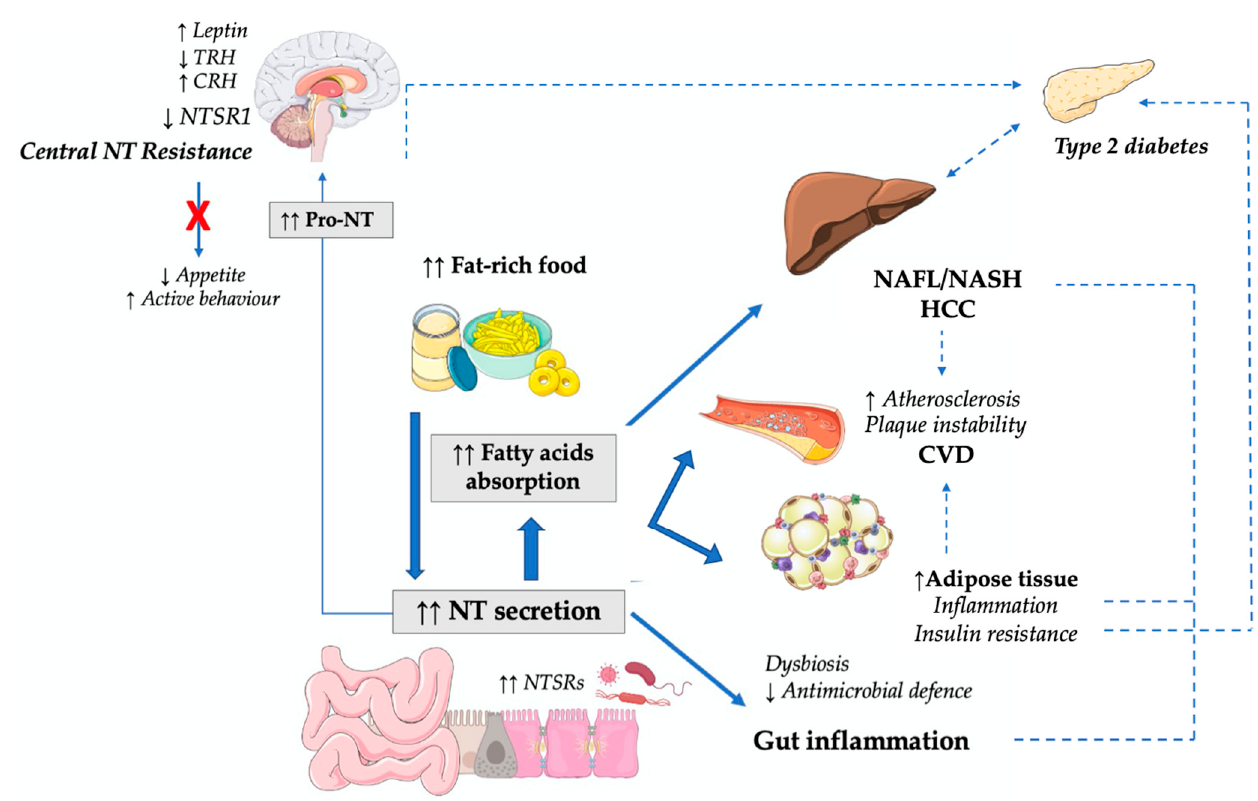
Figure 2. NT in metabolic diseases: potential direct and indirect mechanisms linking high NT to metabolic impairment and cardiovascular disease. Bold arrows indicate direct NT effects, dotted arrows show indirect NT influences on cardio-metabolic risk factors. Abbreviations: CRH: corticotropin-releasing hormone; CVD: cardiovascular disease; HCC: hepato-cellular carcinoma; NAFLD: non-alcoholic fatty liver disease; NASH: non-alcoholic steatohepatitis; NT: neurotensin; NTSR1: neurotensin receptor 1; TRH: thyrotropin-releasing hormone.